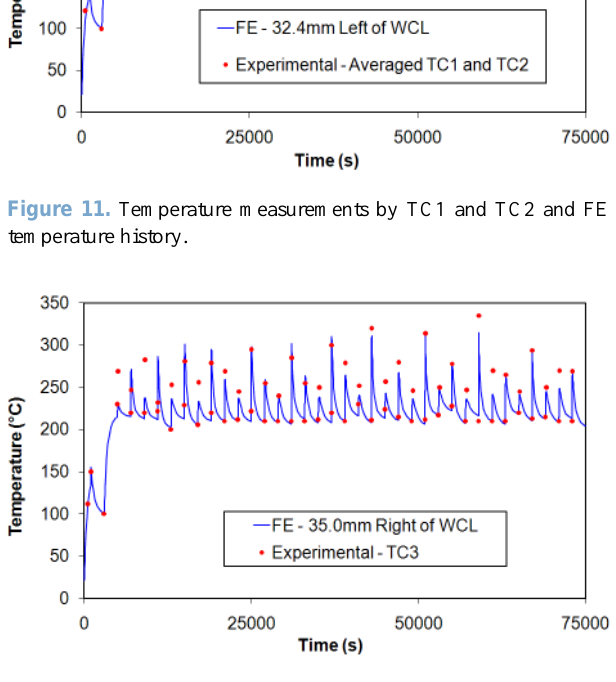
Figure 12. Temperature measurements by TC3 and FE temperature history. Figure 14. Temperature measurements by TC5 and FE temperature history.